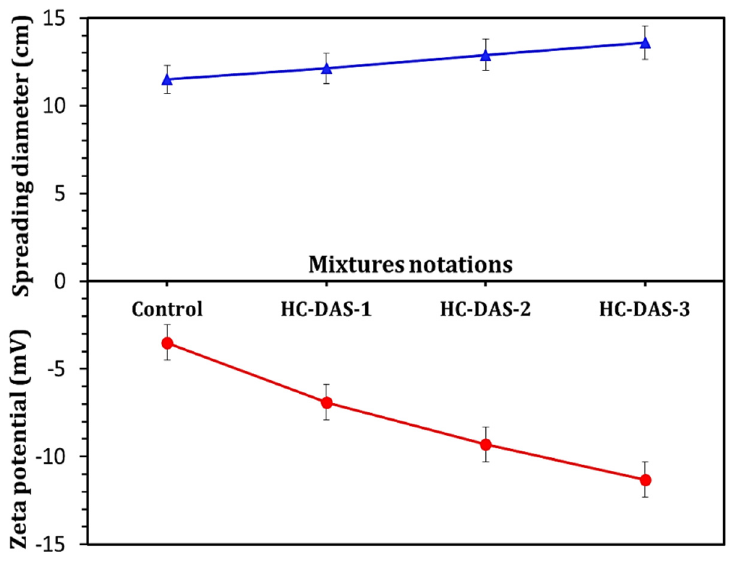
Figure 4. Workability and zeta potential of the fresh control and one-part HC mortars.